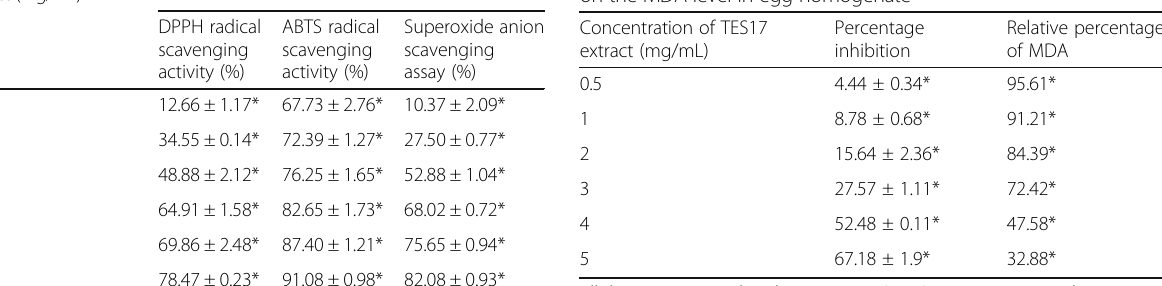
Table 3 The antioxidant activities demonstrated by TES17 extract in different antioxidant assays Concentration of TES17 extract (mg/mL)